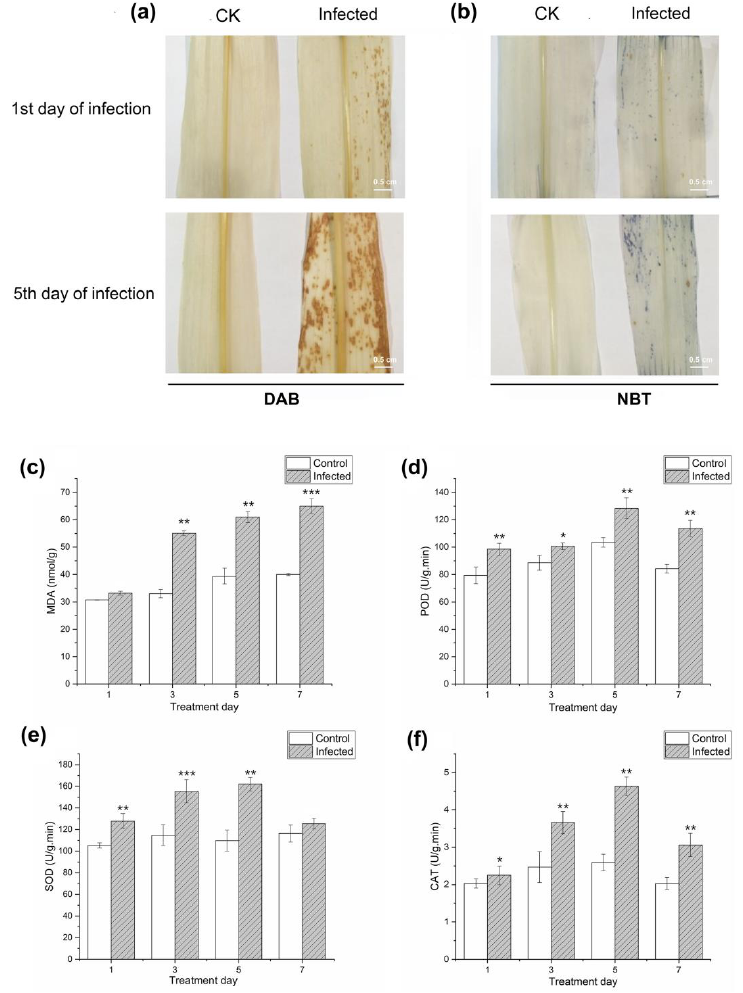
Figure 2. Detection of reactive oxygen species (ROS) accumulation by ( a ) DAB and ( b ) NBT staining in maize leaves and physiological investigation in response to Bipolaris maydis infection, including ( c ) MDA content, ( d ) POD activity, ( e ) SOD activity, and ( f ) CAT activity. (Student’s t -test, * p < 0.05; ** p < 0.01; *** p < 0.001.).